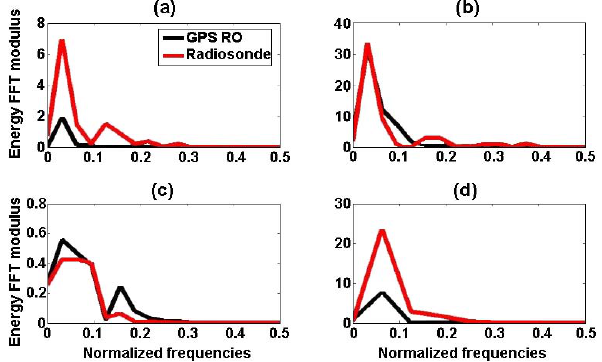
Fig. 7. Fast Fourier transform of collocated GPS RO temperature perturbations on 15 February 2008 in (a) the UT and (b) the LS above Gillot. (c) and (d) same as (a) and (b) but on 16 February 2008 above Ivato ( λ v =100m/normalized frequency).